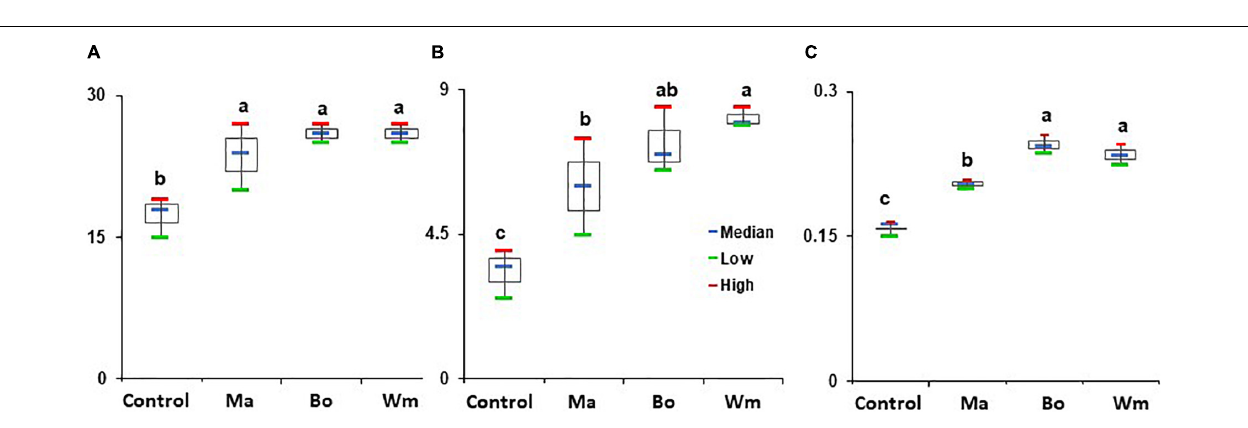
FIGURE 8 | Effect of bacterial isolates on the growth of rice plants. Surface-sterilized rice seeds (cv Shindongjin) were soaked in 1 × 10 8 CFU/ml of bacterial suspensions Bacillus oceanisediminis (Ba), Methylobacterium aquaticum (Ma), and Williamsia muralis (Wm). The seeds treated with sterile DW amended with 0.2% CMC served as control. (A) Shoot height (cm), (B) root length (cm), and (C) fresh weight (g) of rice plants were measured after 2 weeks of growth. The experiment consisted of three replicates of 10 seeds each, and the experiment was repeated three times. Red and green represent the high and low, respectively, whereas the horizontal blue bars within boxes represent the median. The tops and bottoms of boxes represent the 75th and 25th quartiles, respectively. Different letters indicate statistically significant differences among